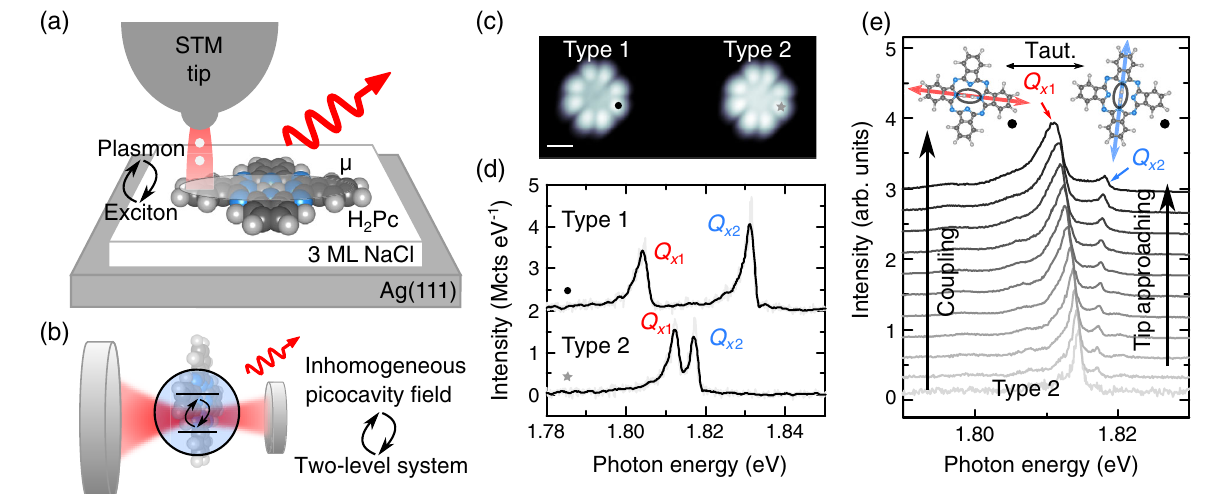
FIG. 1. (a) Sketch of the experiment where the plasmonic silver tip of a STM is used to excite the fluorescence of a single H 2 Pc molecule deposited on a NaCl-covered Ag(111) sample. The orientation of the molecular dipole ( μ ) is schematically marked by a gray ellipse. (b) Sketch of the system where an extended two-level system (molecule) interacts with the confined electromagnetic field of the plasmonic picocavity. (c) STM image ( V ¼ − 2 . 5 V, I ¼ 10 pA, scale bar: 1 nm). (d) STML spectra ( V ¼ − 2 . 5 V, I ¼ 200 pA, t ¼ 120 s) of a type-1 and a type-2 H 2 Pc (see main text for detail) acquired at positions marked by a black dot and gray star in panel (c). (e) Successive STML spectra acquired during the vertical approach of the STM tip to a H 2 Pc molecule of type 2. Note that V ¼ − 2 . 5 V, that I ranges from 2 pA (bottom spectrum) to 500 pA (top spectrum) whereas t ranges from 360 s to 30 s. Inset: ball-and-stick models of two H 2 Pc tautomers with the Q and Q dipoles marked by red and blue arrows, respectively. The hydrogen atoms are marked by x 1 x 2 ellipses. The black dots indicate the tip